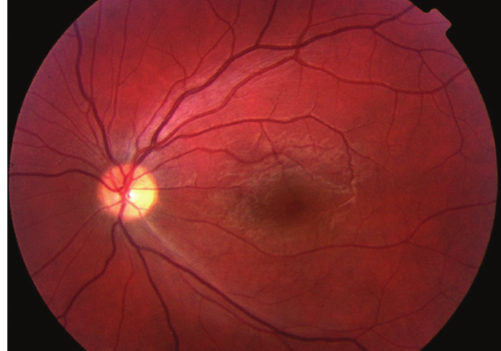
Figure 2: Colour photograph of left fundus 1 month after initial artery occlusion showing marked resolution in signs and sclerosis of